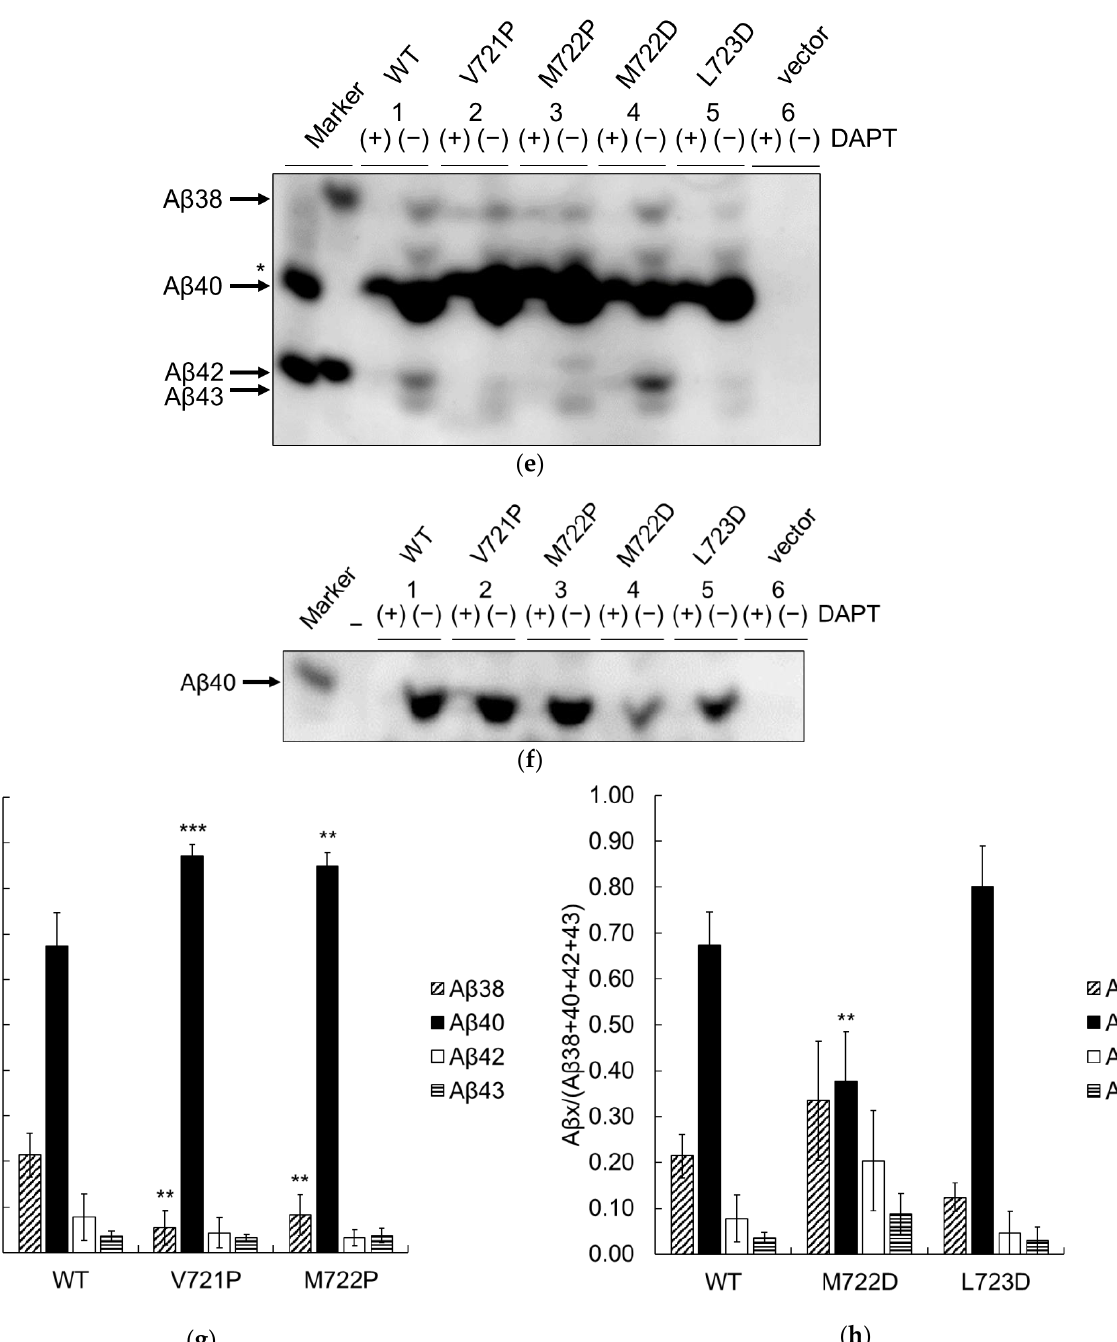
Figure 8. Aβ production by secondary APP mutations in Chinese hamster ovary (CHO) cells. CHO cells were transfected with WT or mutant APPC99, and an empty vector through lipofection. ( a ) Aβ secreted in the media, and APP C99 or α-tubulin in cell lysates, were analyzed by immunoblotting, as shown in Figure 7; ( b ) Cleavage rates (Aβ/C99) were quantified using three independent assays and are presented with standard deviations; ( c , d ) Aβ secreted from the recovered media was quantified by two-site ELISA using three independent assays and is presented with standard deviations, as shown in Figure 7; ( e , f ) The recovered media were also analyzed by urea/SDS-PAGE at pH 8.45 ( e ) or pH8.65 ( f ) and secreted Aβ was detected using 82E1. Numbers 1-6 denotes lane numbers; ( g , h ) The proportions of each Aβ fragment were determined using four independent assays and are shown with the standard deviations. Asterisks indicate p < 0.001 (***) or p < 0.01 (**) compared to the WT.